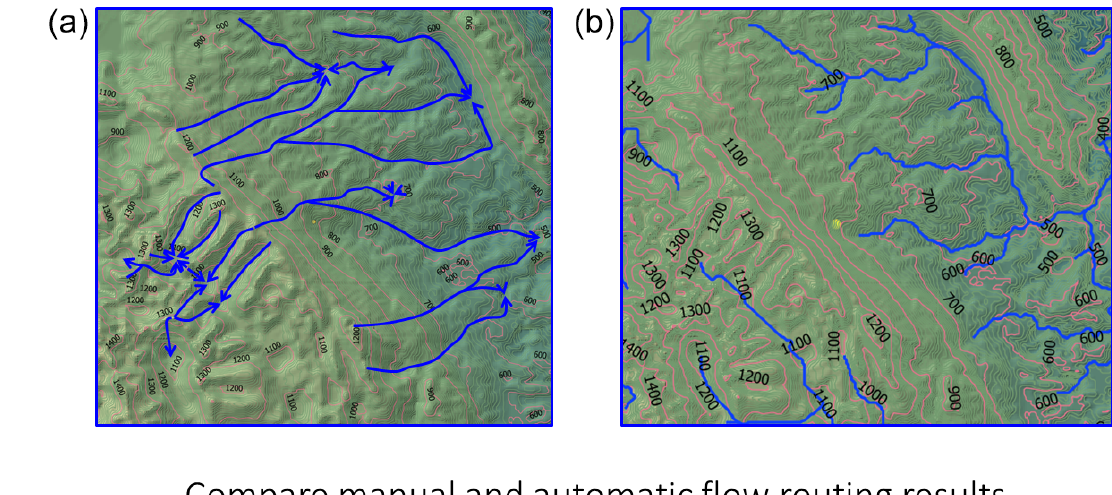
Figure 7. Manually drawn water flow routing (a) and automated flow routing (b) performed in